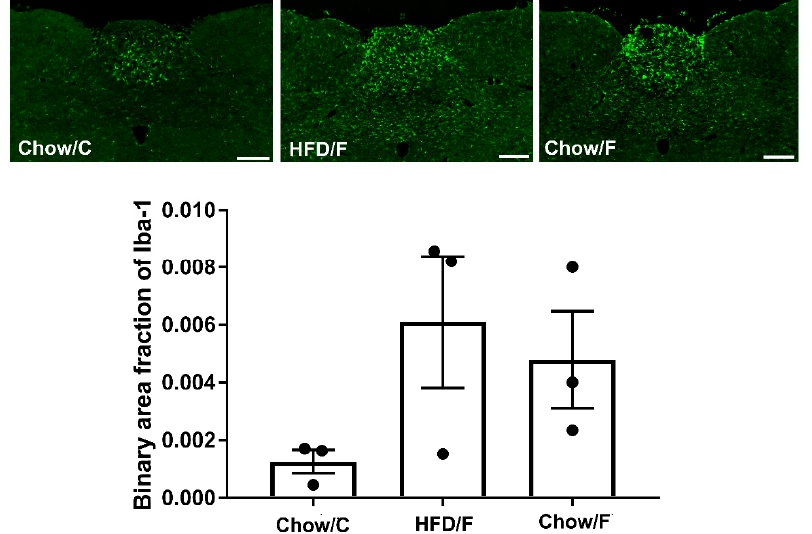
Figure 7. Manipulating the gut microbiome through a cecal fistula did not trigger increased microglia activation in the intermediate NTS. Representative sections of intermediate NTS of animals fed a high-fat diet for seven weeks (HFD/F, n = 3) and rats fed regular chow (Chow/C and Chow/F, n = 3 respectively) are shown. Binary analysis of the area fraction of Iba1 immunoreactivity showed no significant difference in microglia activation between the groups. We can appreciate greater individual variability in the HFD/F and Chow/F groups than in the Chow/C cohort. Graphs represent mean + SEM Iba1 intensity. Scale bar = 200 μ m.